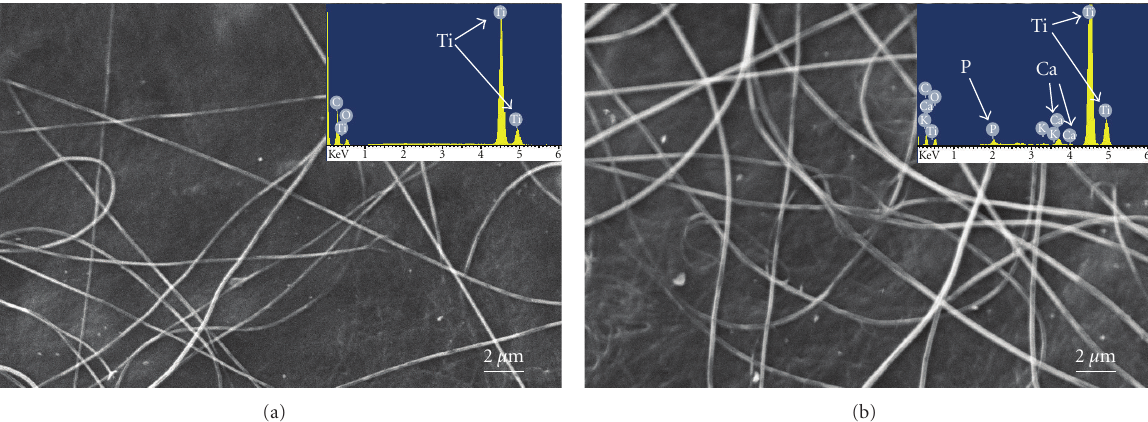
Figure 3: Scanning electron microscopy (SEM) images and energy dispersive X-rays (EDAX) analysis of electrospun pure collagen (a) and collagen-hydroxyapatite composite (b).